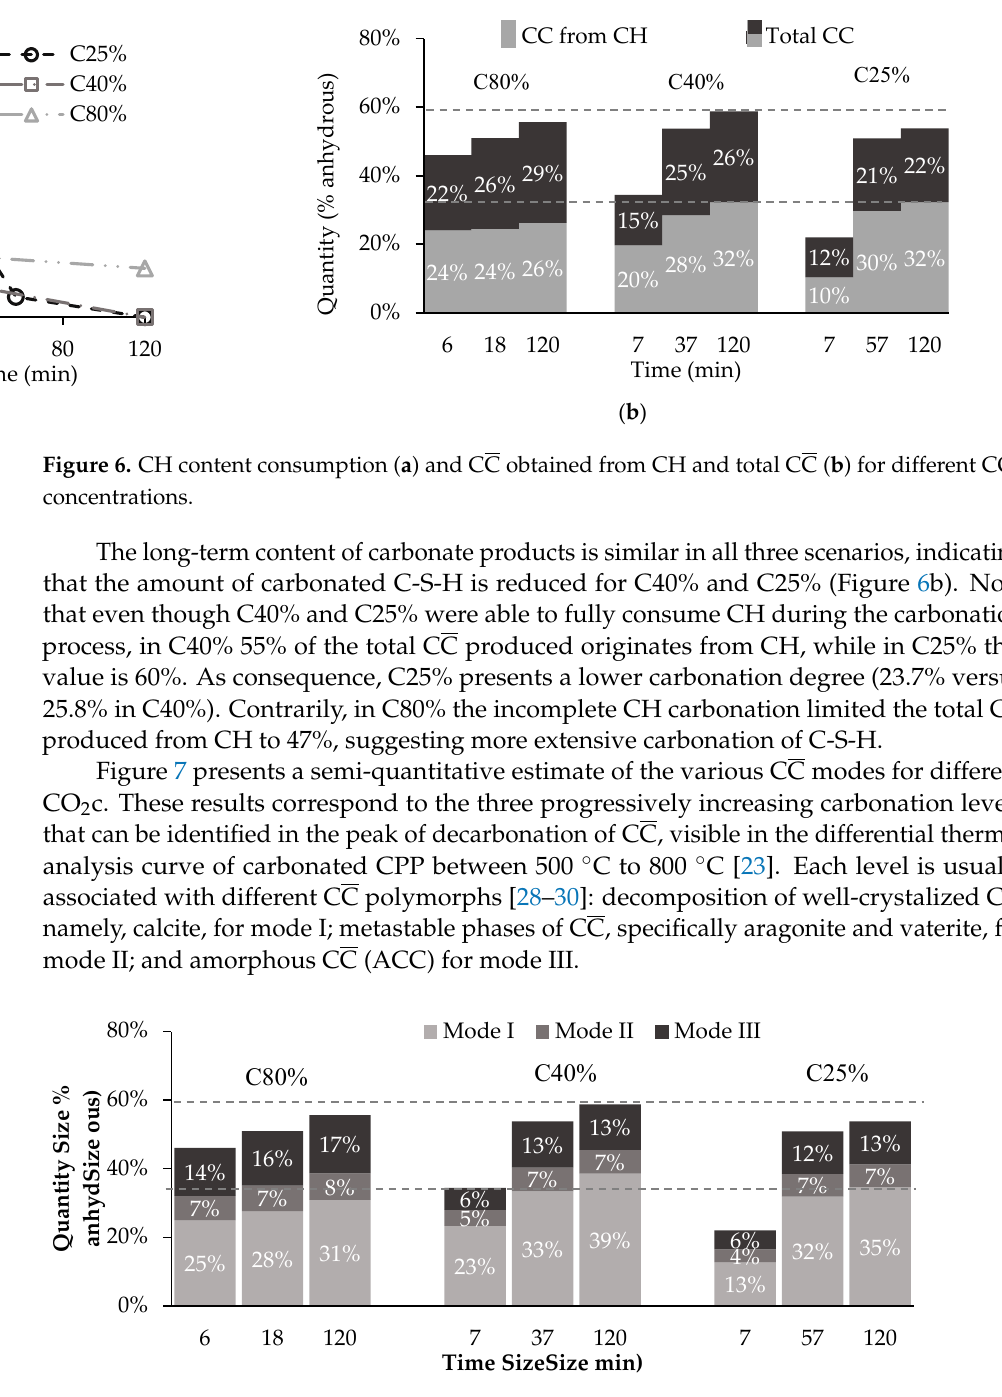
Figure 7. Different CC(cid:3364) modes (I, II and III) present in each CO 2 concentration test.